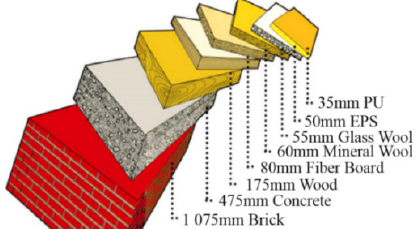
Figure 4. Comparison of the thickness of different insulation materials with identical thermal con- ductivity.